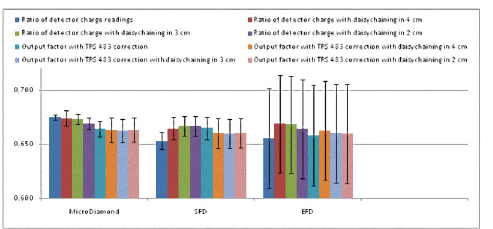
Fig 3. Ratio of detector readings and OFs for the 0.6 × 0.6 cm 2 field for the 6 MV beams with different detectors. Results with daisy chaining in 4 x 4 cm 2 , 3 x 3 cm 2 , and 2 x 2 cm 2 are included.